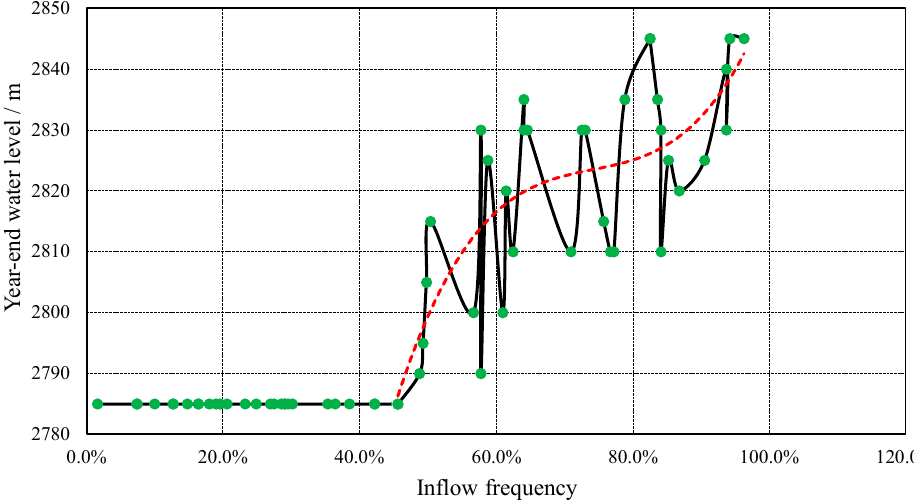
Figure 7. Optimal year-end water levels under different inflow frequencies.